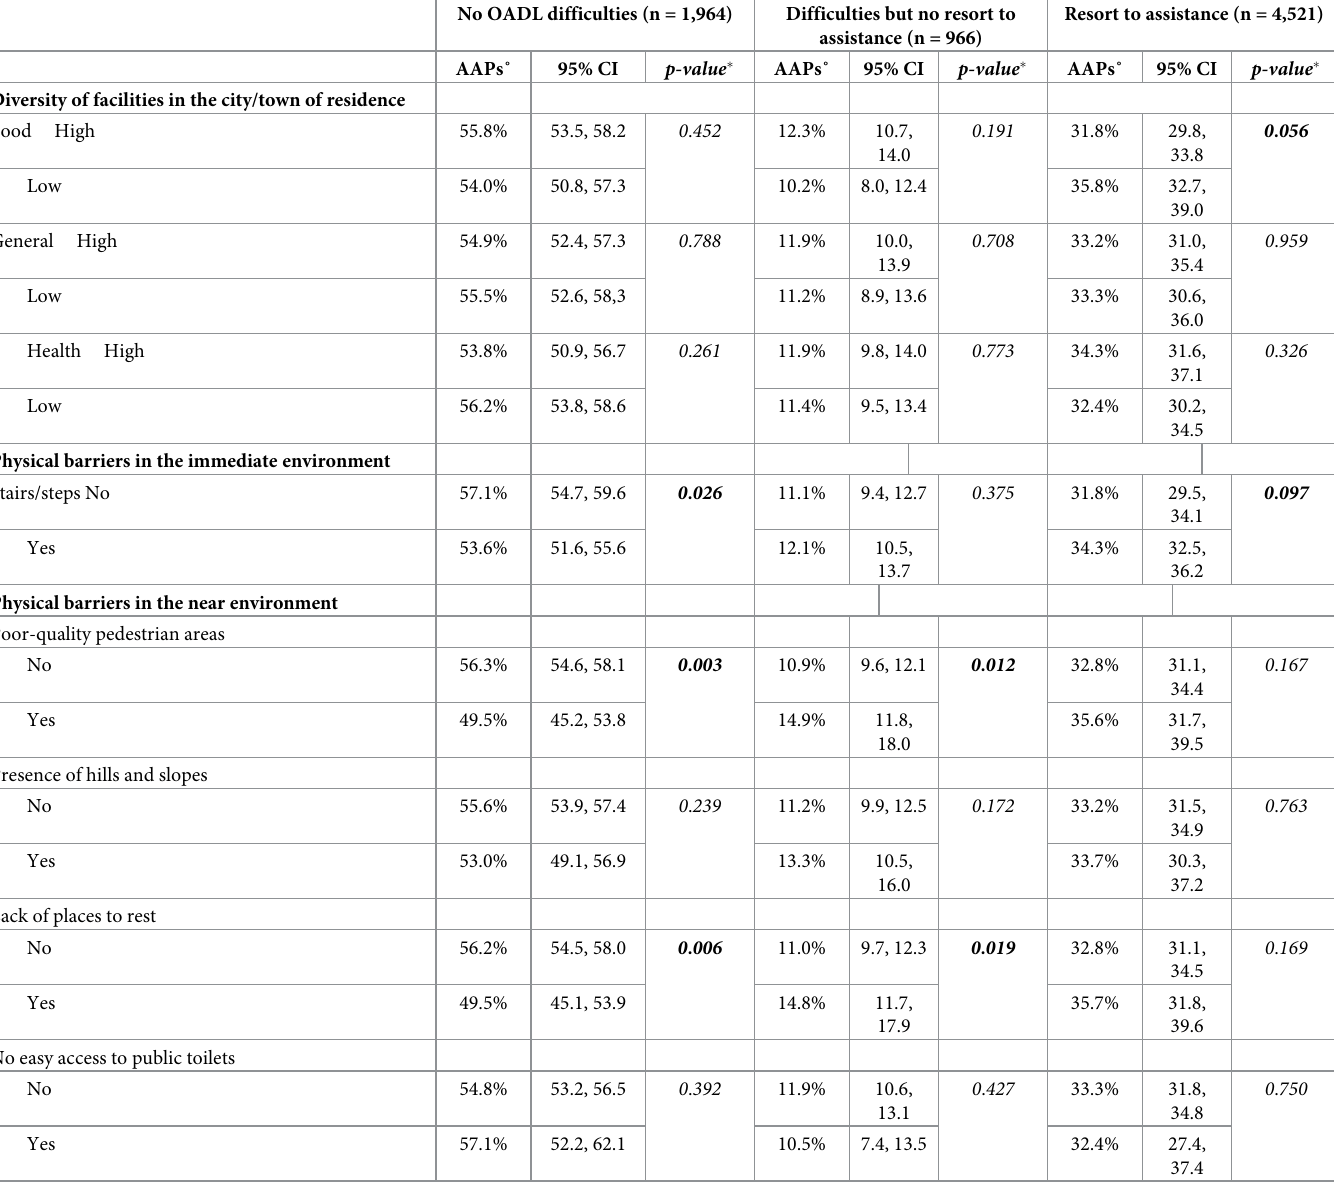
Table 2. Average Adjusted Predictions (AAPs)˚ of OADL difficulties and resort to assistance (Model 1). CARE-Seniors Me´nages Survey (60+ with at least 1 FL), 2015, France. No OADL difficulties (n =